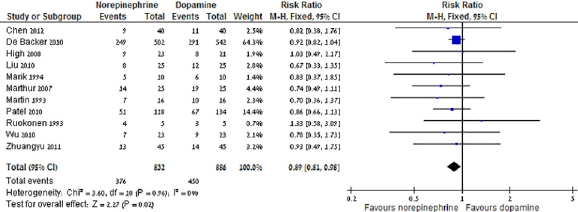
Fig 3. Norepinephrine versus dopamine, 28 days all-cause